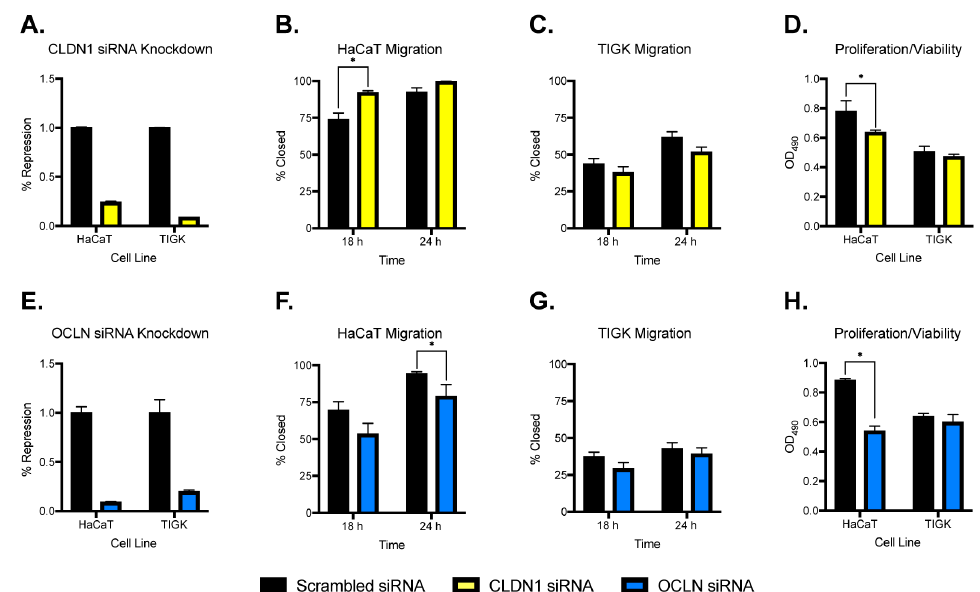
Figure 5. Migration and proliferation / viability of skin and oral keratinocytes after CLDN1 or OCLN knockdown. For migration assays, HaCaT and TIGK cells were transfected with claudin 1 or occludin small interfering RNA (siRNA). The transfected cells were cultured in 2-well silicone culture inserts with a defined cell-free gap as described in the Materials and Methods section. Cell migration was documented by a digital camera 18 and 24 h later. For proliferation / viability assays, 5 × 10 3 cells / well of claudin 1 or occludin siRNA-transfected HaCaT and TIGK cells were plated in a 96-well plate. A 3-(4,5-dimethylthiazol-2-yl)-5-(3-carboxymethoxyphenyl)-2-(4-sulfophenyl)-2H-tetrazolium, inner salt (MTS) proliferation assay was performed to record OD 490 values corresponding to the numbers of live cells using a spectrophotometer. ( A ) CLDN1 knockdown in HaCaT and TIGK cell lines. ( B , C ) Migration after CLDN1 knockdown in HaCaT and TIGK cells, respectively. ( D ) Proliferation / viability after CLDN1 knockdown. ( E ) OCLN knockdown in HaCaT and TIGK cell lines. ( F , G ) Migration after OCLN knockdown in HaCaT and TIGK cells, respectively. ( H ) Proliferation / viability after OCLN knockdown. Black = scrambled siRNA, yellow = CLDN1 siRNA, blue = OCLN siRNA; n = 3 replicates, * p < 0.05.